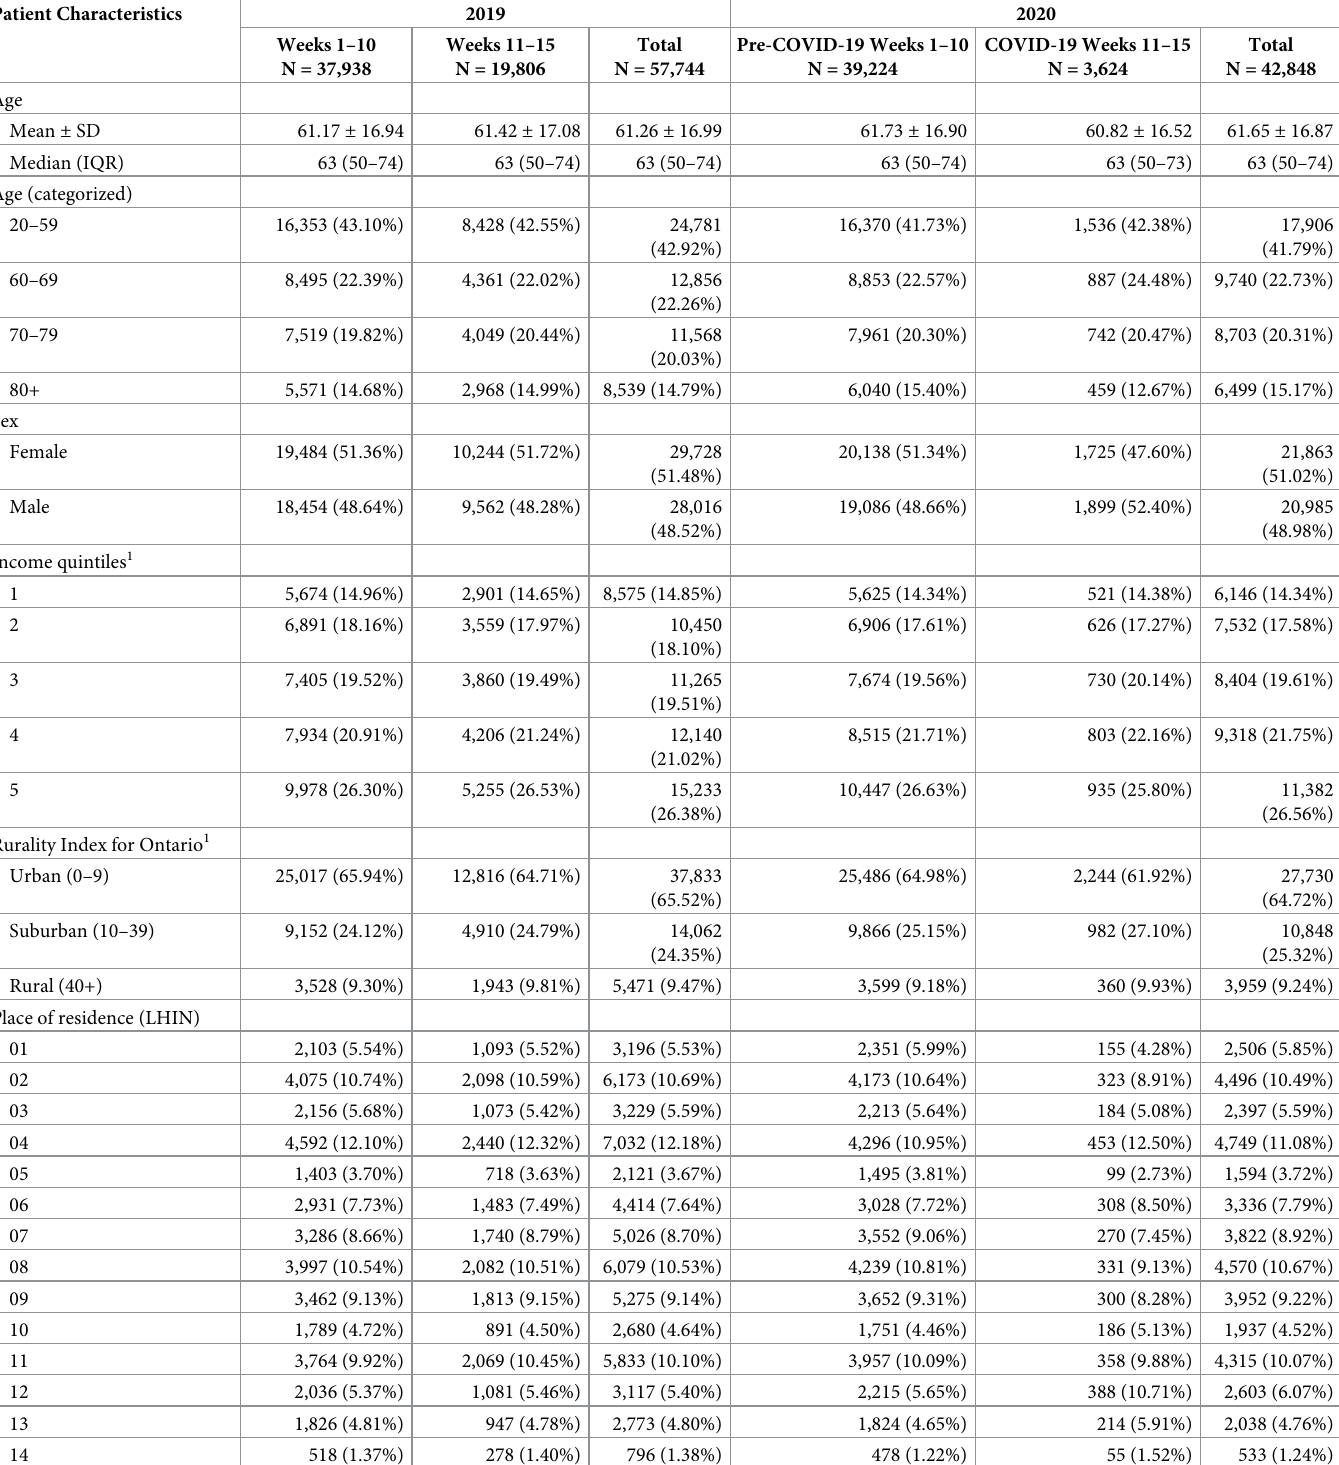
Table 1. Patient characteristics for all biopsy claims for the first 15 weeks (starting on Monday) of 2019 and